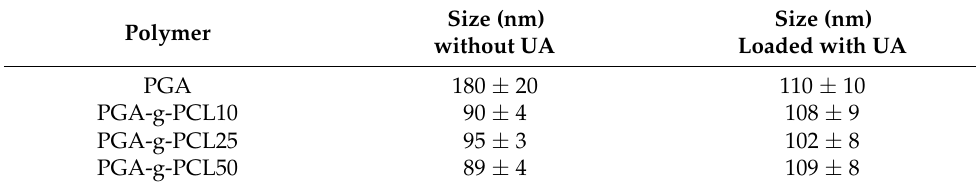
Table 2. Size of PGA and PGA-g-PCL nanoparticles with or without usnic acid.